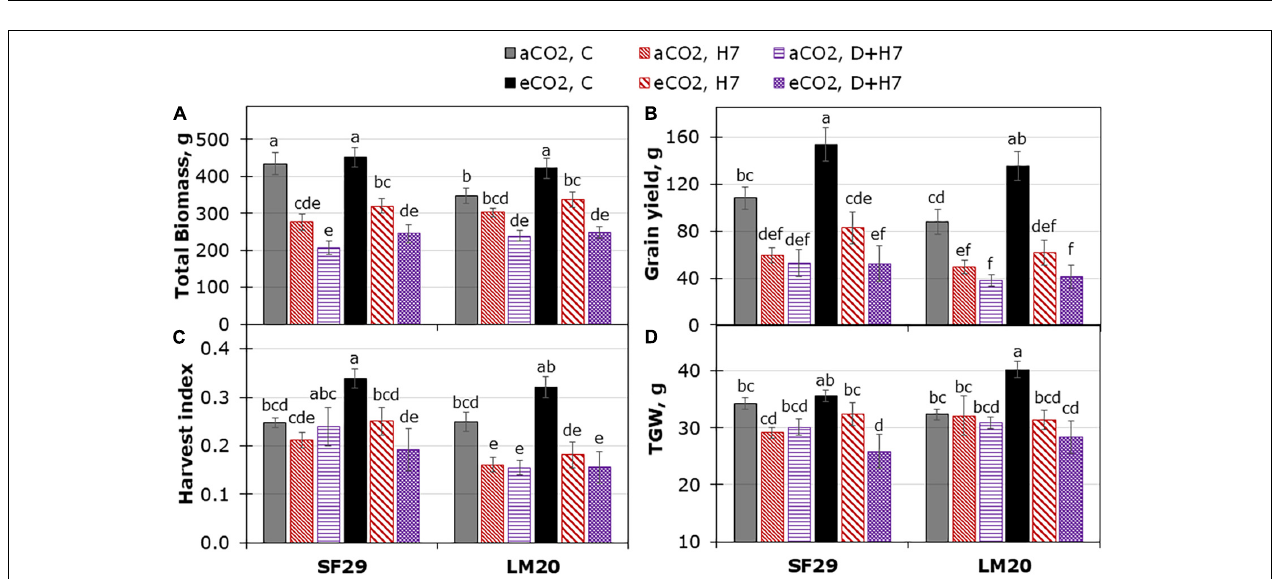
FIGURE 6 | Yield-related traits during the ripening stage. (A) Total biomass (DW), (B) grain yield (C) harvest index, and (D) thousand-grain weight (TGW) per plant in heat-sensitive (SF29) and heat-tolerant (LM20) genotypes grown under control conditions (C), heat stress at Day 7 (H7) and combined heat stress and drought at Day 7 (D + H7) at ambient CO 2 (aCO 2 ) or elevated CO 2 (eCO 2 ). The data represent mean values ± S.E. ( n = 8). Different small letters indicate significant differences within variants according to Duncan’s test after ANOVA ( p <